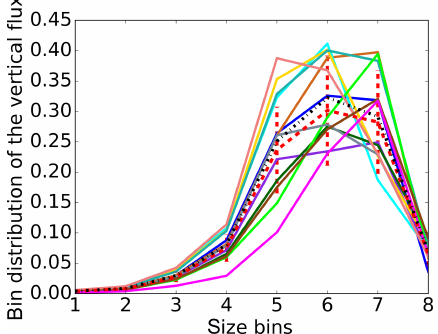
Figure 1. Distribution of the mass vertical flux at sources across the eight dust transport bins for the different ensemble members in dif- ferent colours, where the bin sizes from bin 1 to bin 8 go from 0.1 to 10µm with division intervals at 0.18, 0.3, 0.6, 1, 1.8, 3, and 6µm. The distribution derived from D’Almeida (1987), and used in the standard forecast, is the dashed red line, with horizontal bars indi- cating the standard deviation of the noise used to create the pertur- bations. The mean of the ensemble perturbations is the dash-dotted